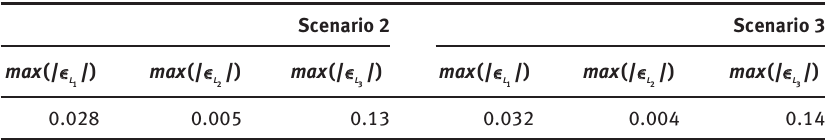
Table 5. Maximum of the Absolute Errors between the Outputs of the Model and the Measured Levels for Scenario 2 and Scenario 3 in Meters [ m